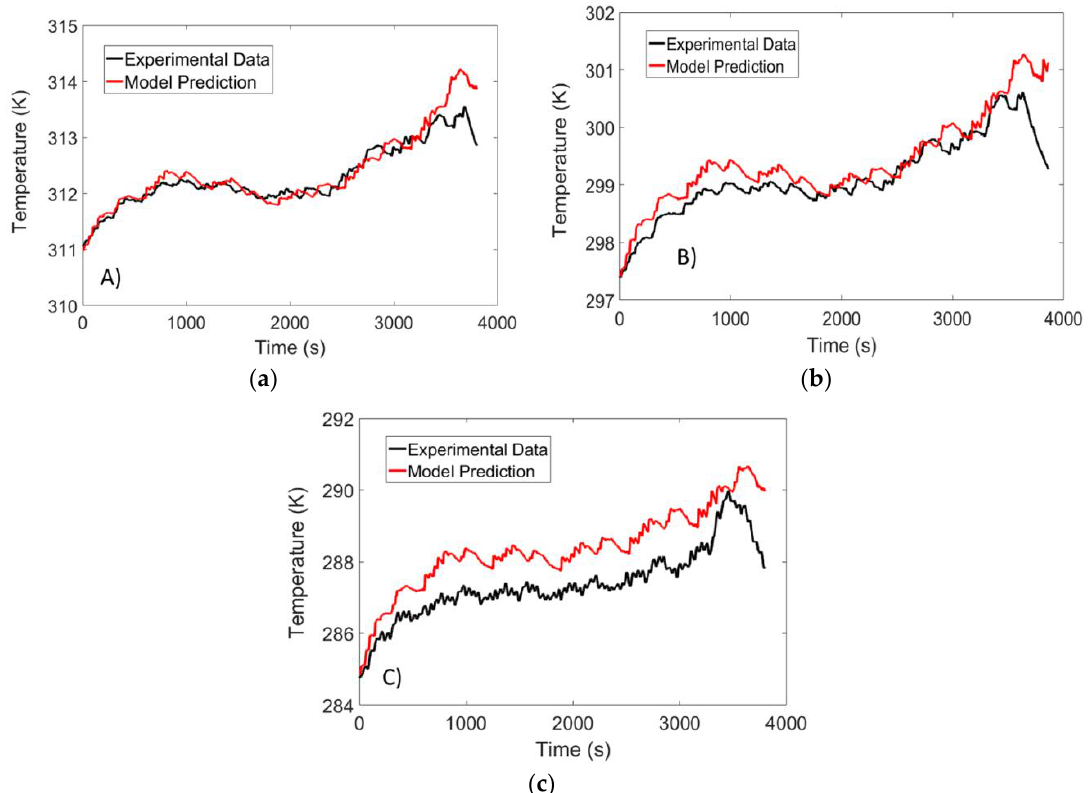
Figure 12. Temperature response of a LFP battery subject to a US-06 drive cycle at ambient temperatures of: ( a ) 40 °C; ( b ) 25 °C; and ( c ) 10 °C.